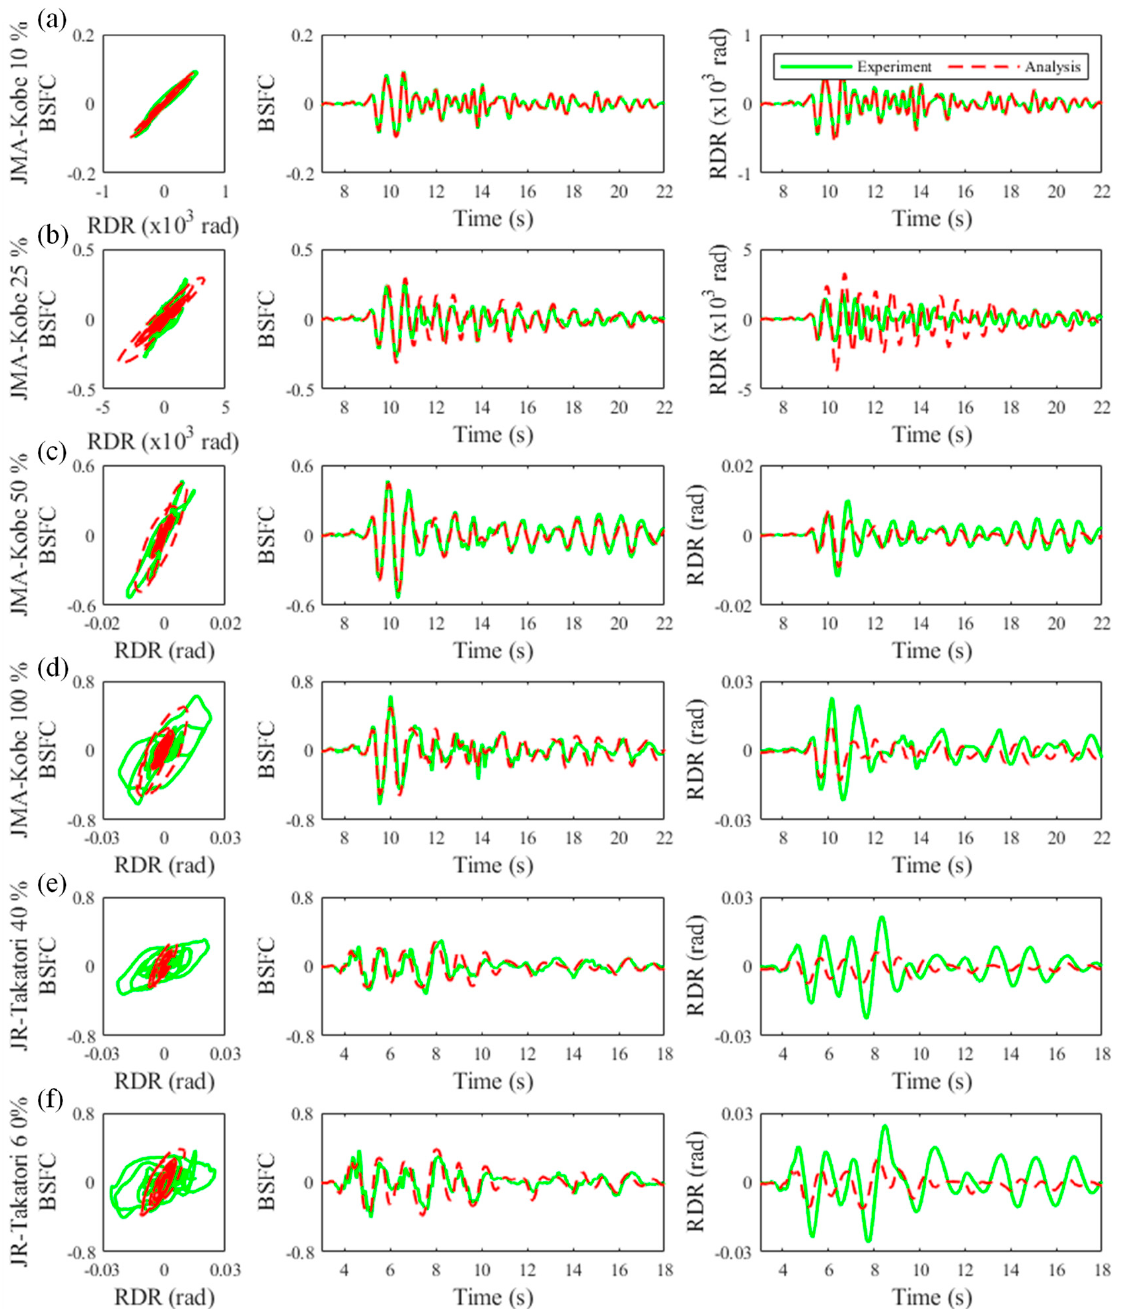
Figure 9. Comparison between hysteresis loops of base shear force coefficient (BSFC) and roof drift ratio (RDR) obtained from experiments and analyses: ( a ) JMA-Kobe 10% amplitude experiment, ( b ) JMA-Kobe 25% amplitude experiment, ( c ) JMA-Kobe 50% amplitude experiment, ( d ) JMA-Kobe 100% amplitude experiment, ( e ) JR-Takatori 40% amplitude experiment, and ( f ) JR-Takatori 60% amplitude experiment.